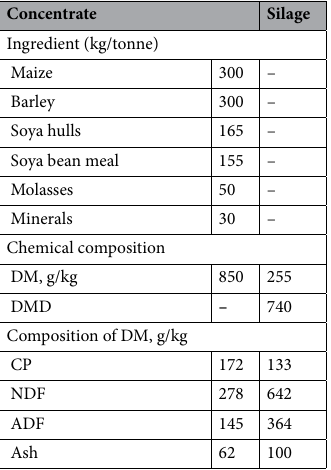
Table 11. Ingredient and chemical composition of concentrate and silage offered to lambs. DMD dry matter